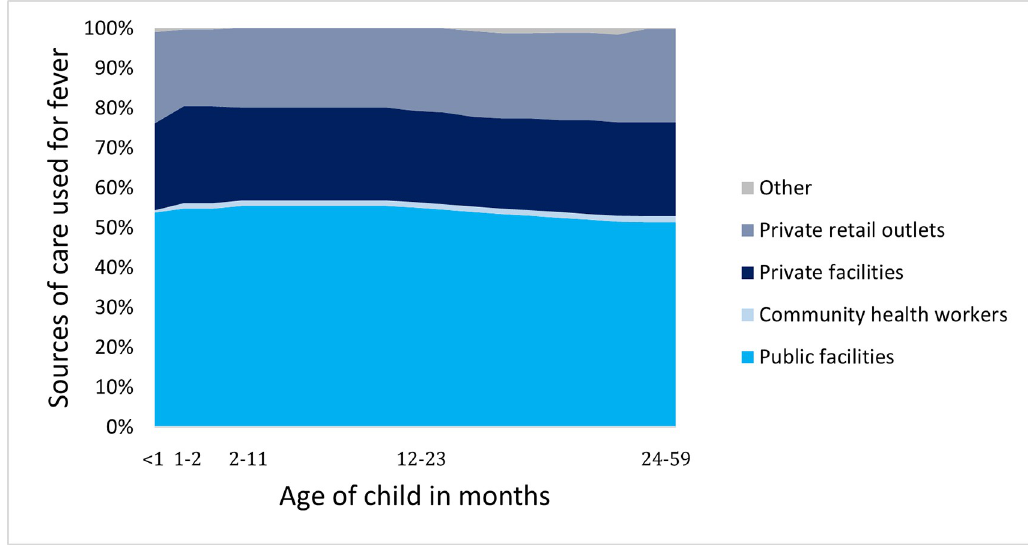
Fig 6. Sources for care by age group, among children in each age group sick with fever whose caregivers sought treatment or advice outside the home.